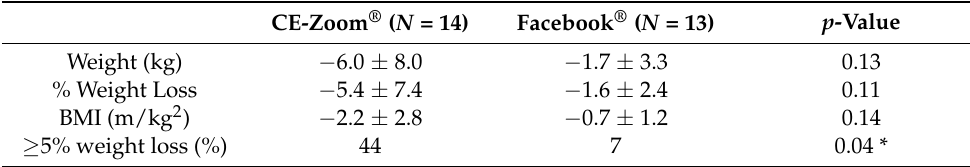
Table 3. Changes in weight and BMI at 6 months.